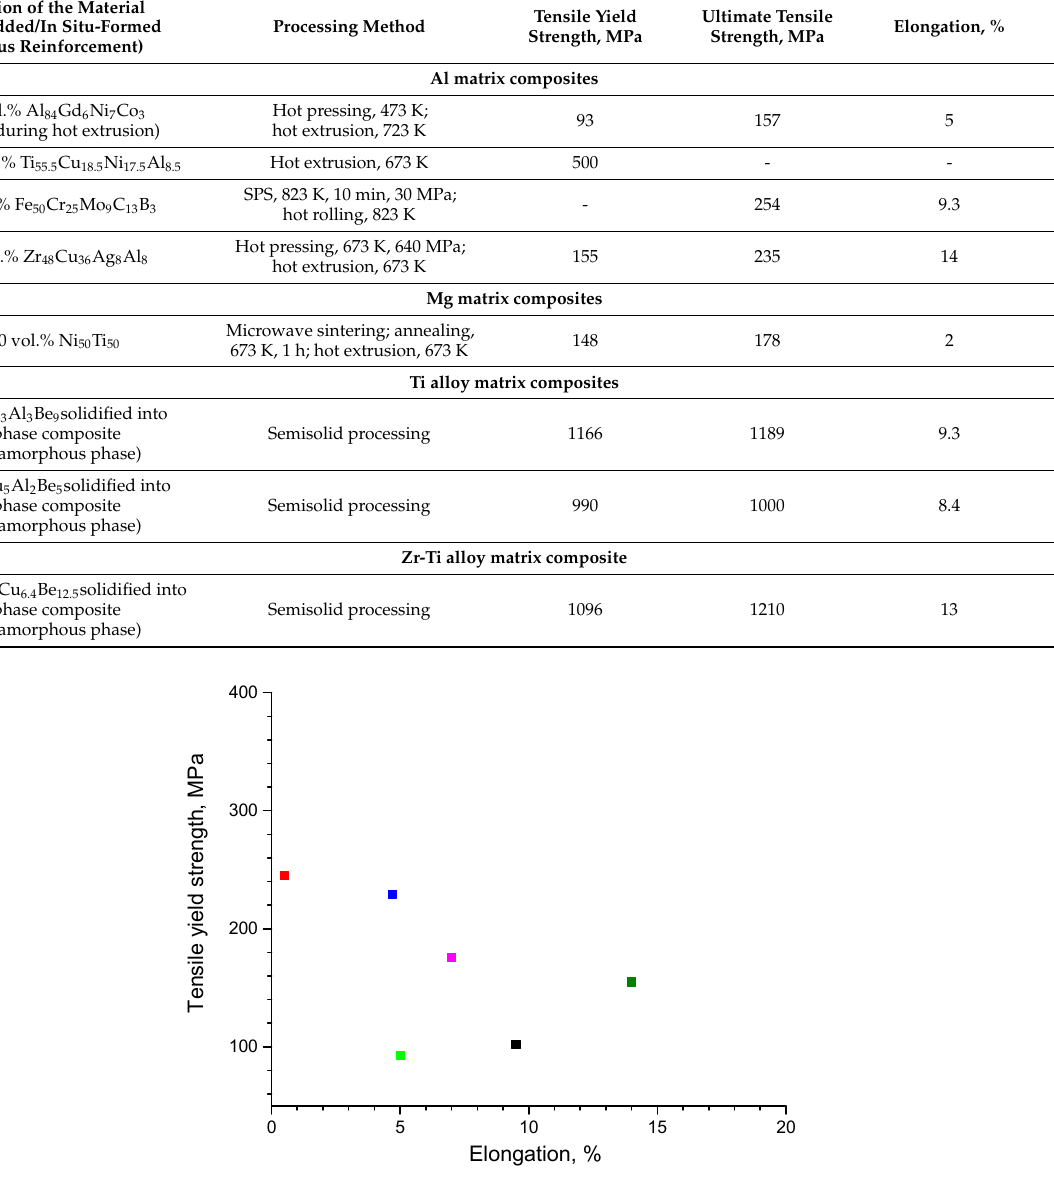
Figure 18. Tensile yield strength–elongation data for Al and Al alloy matrix composites: (cid:4) Al + Ni 60 Nb 40 [55]; (cid:4) Al-Zn-Ca + Co 48 Cr 15 Mo 14 C 15 B 6 Tm 2 [73]; (cid:4) , (cid:4) Al 2024 + Ni 60 Nb 40 [55];